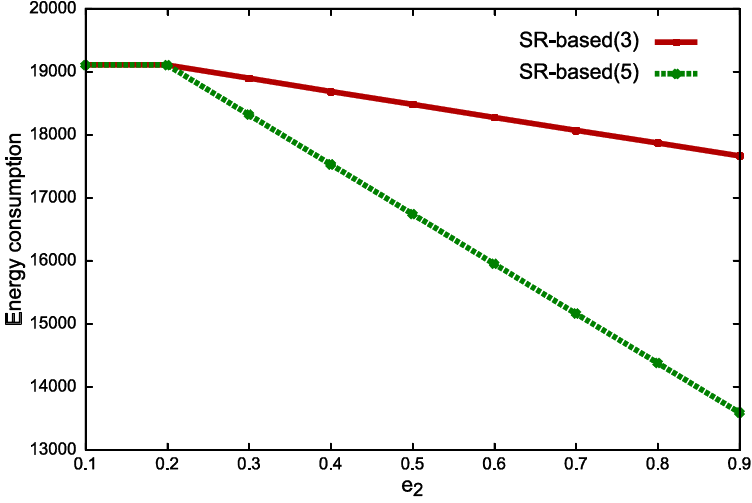
Figure 10. Relation between energy consumption and the defined energy